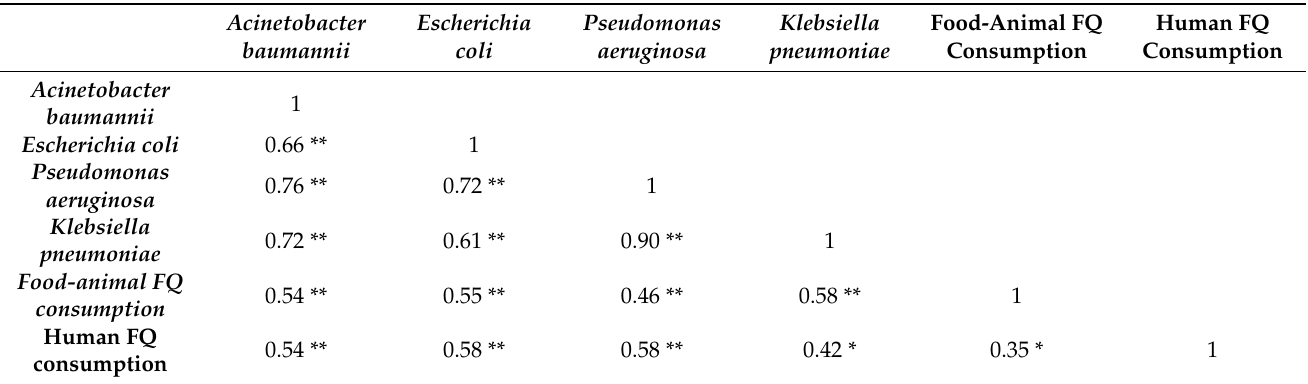
Table 2. Spearman’s correlation matrix of country-level prevalence of fluoroquinolone (FQ) resistance (%) in 4 bacterial species and quinolone consumption in food-producing animals (milligrams of quinolones used for animal food produc- tion/PCU) and fluoroquinolone consumption in humans (defined daily doses/1000 inhabitants per